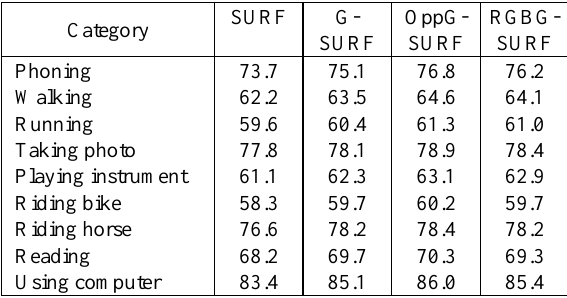
Except SURF and G-SURF, all four types of color G-SURF were calculated in corresponding color spaces. The